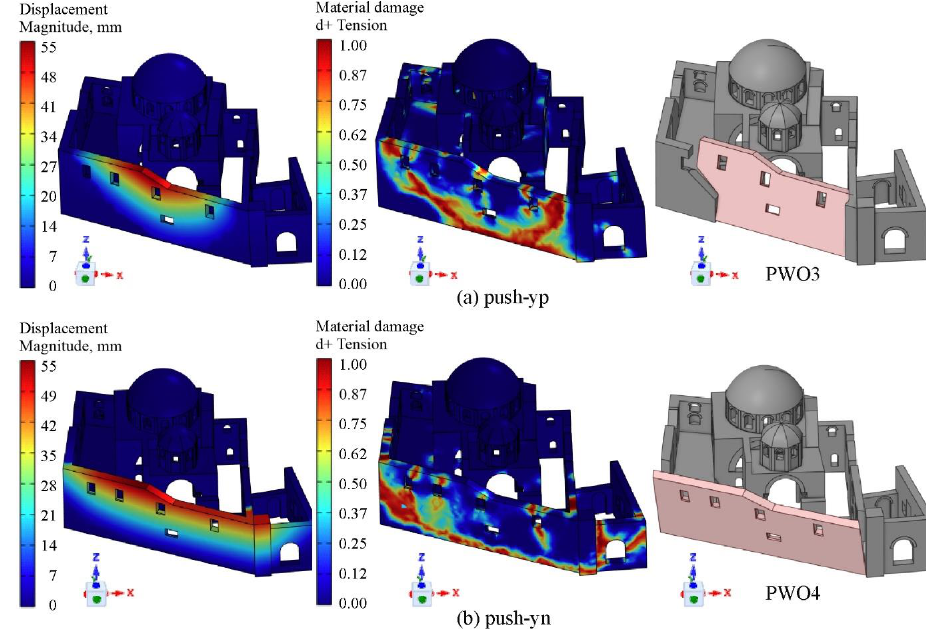
Figure 24. Displacements, damages and failure mechanisms of perimeter walls in push-y directions.